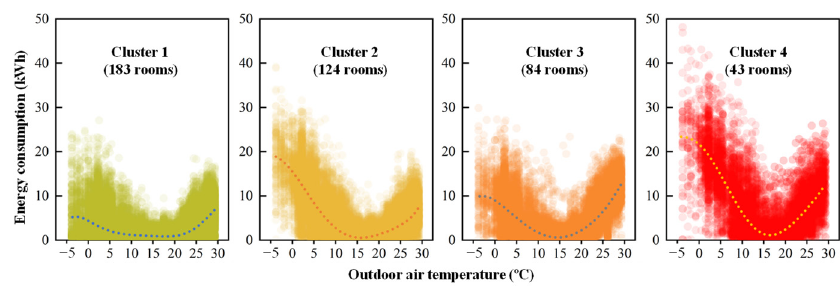
Figure 9. Energy signature of each